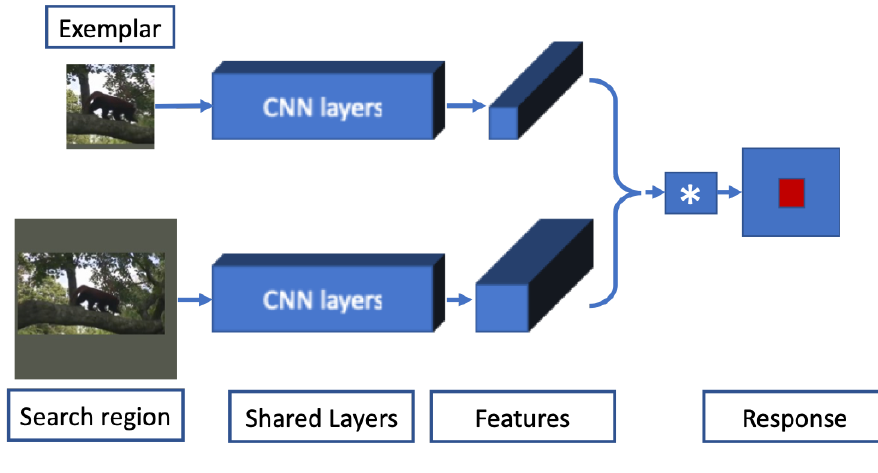
Figure 4. SiamFC network architecture